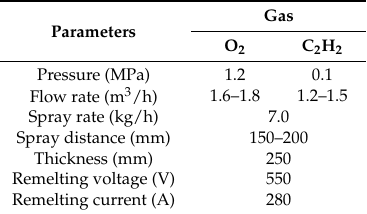
Table 2. Oxy-acetylene flame spraying parameters.